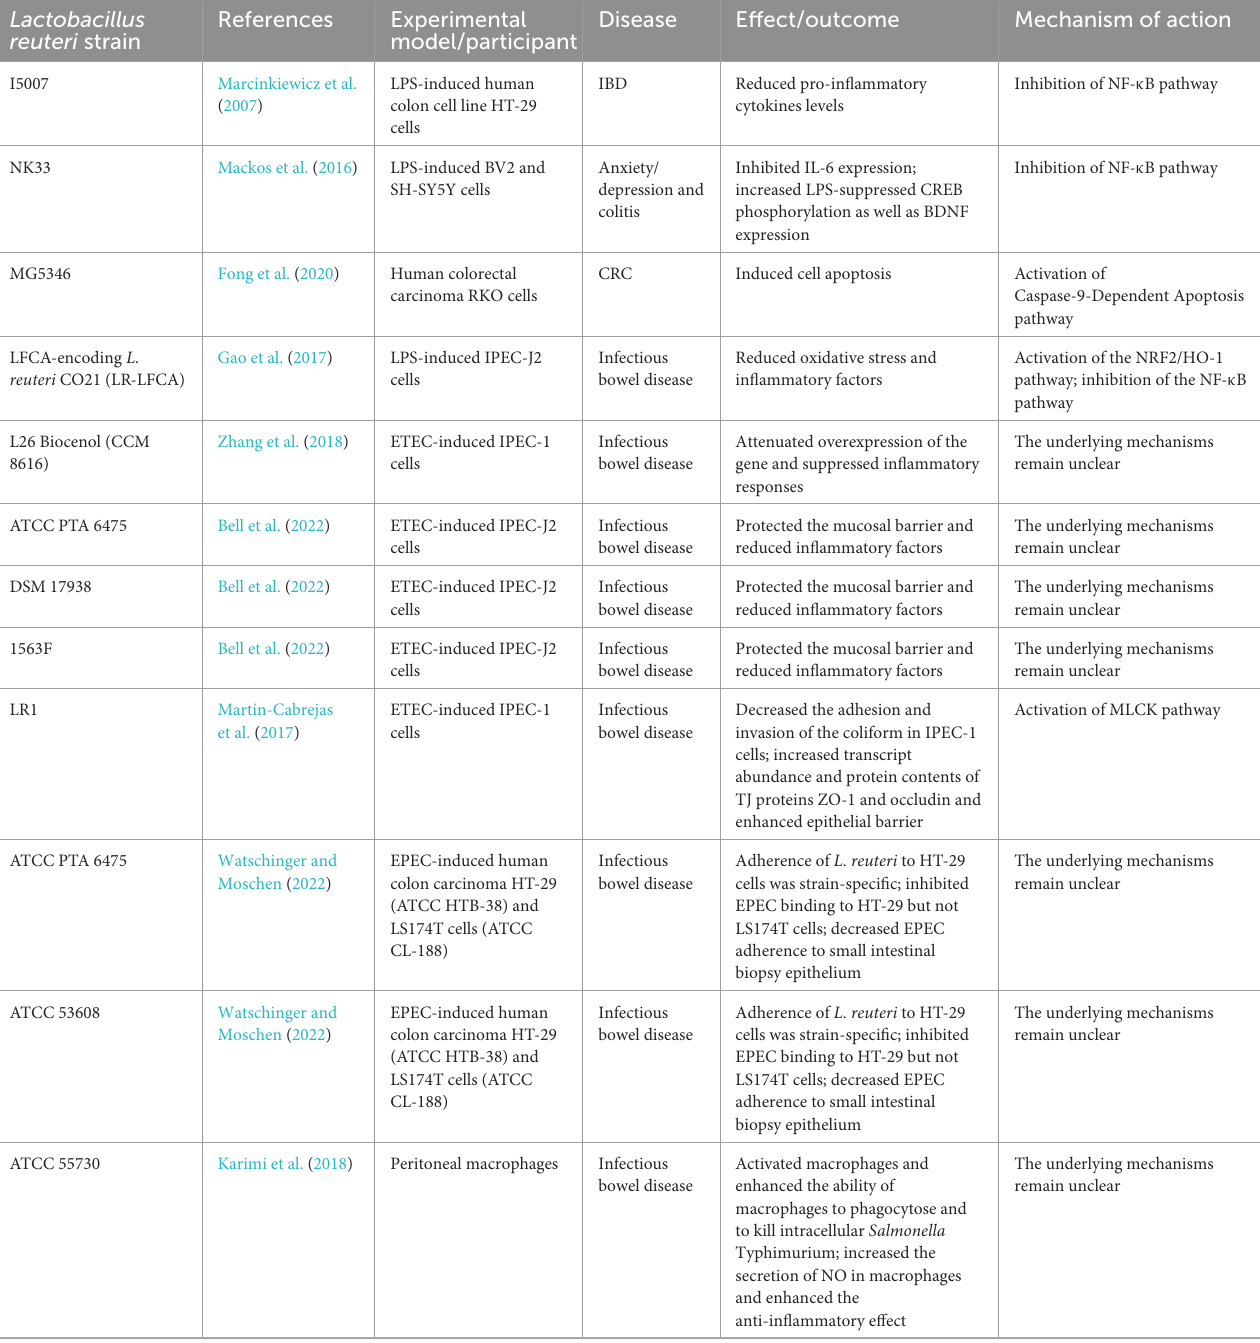
TABLE 1 Therapeutic efficacy and potential mechanisms of Lactobacillus reuteri strains in various intestinal diseases in cell models. Lactobacillus reuteri